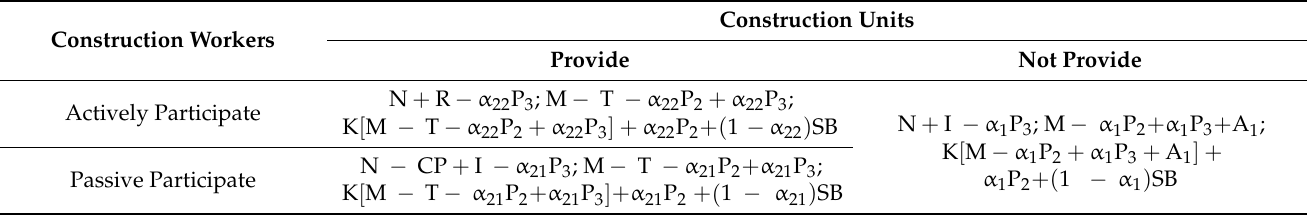
Table 3. Payoff matrix for Government–Construction Unit–Construction Workers (government not participate). Construction Workers